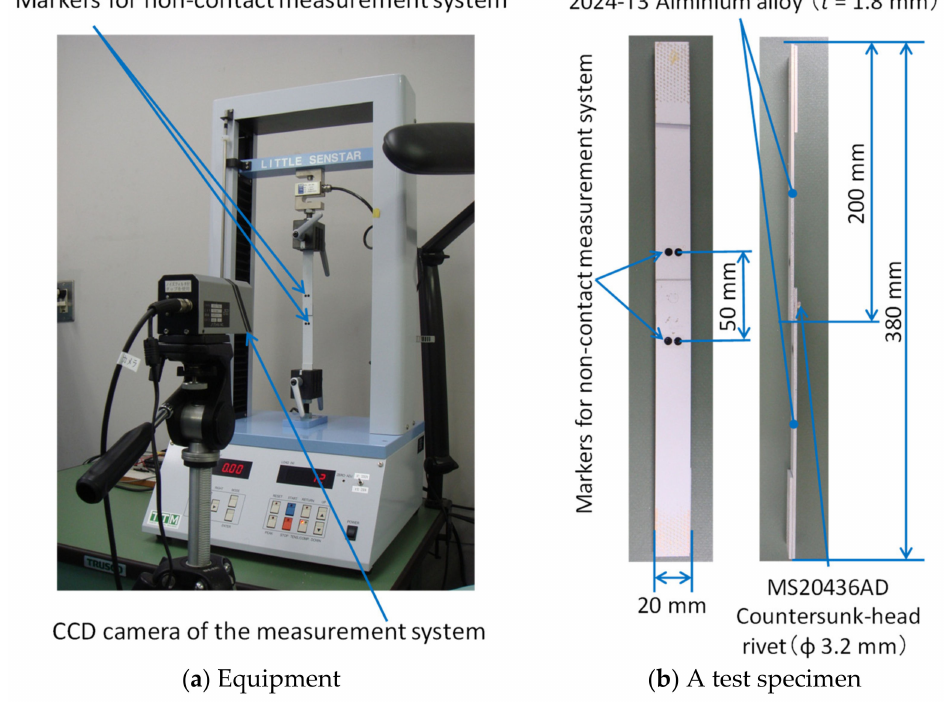
Figure 3. Experimental setup for tensile tests of a single-row